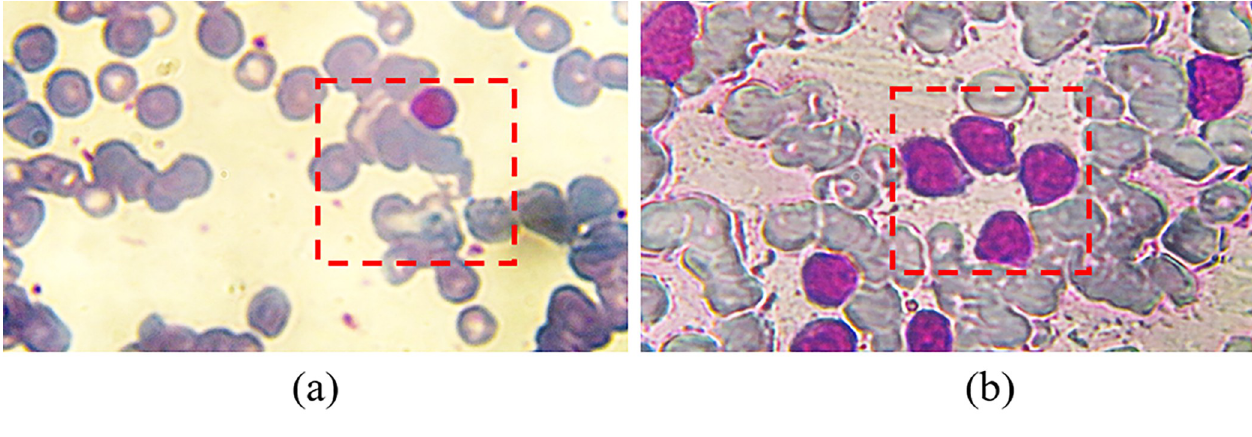
Fig 2. PBF images: (a) normal, and (b) cancer blood samples with a magnification of 60X. Note that, the depicted images are captured at NILES, Cairo University.